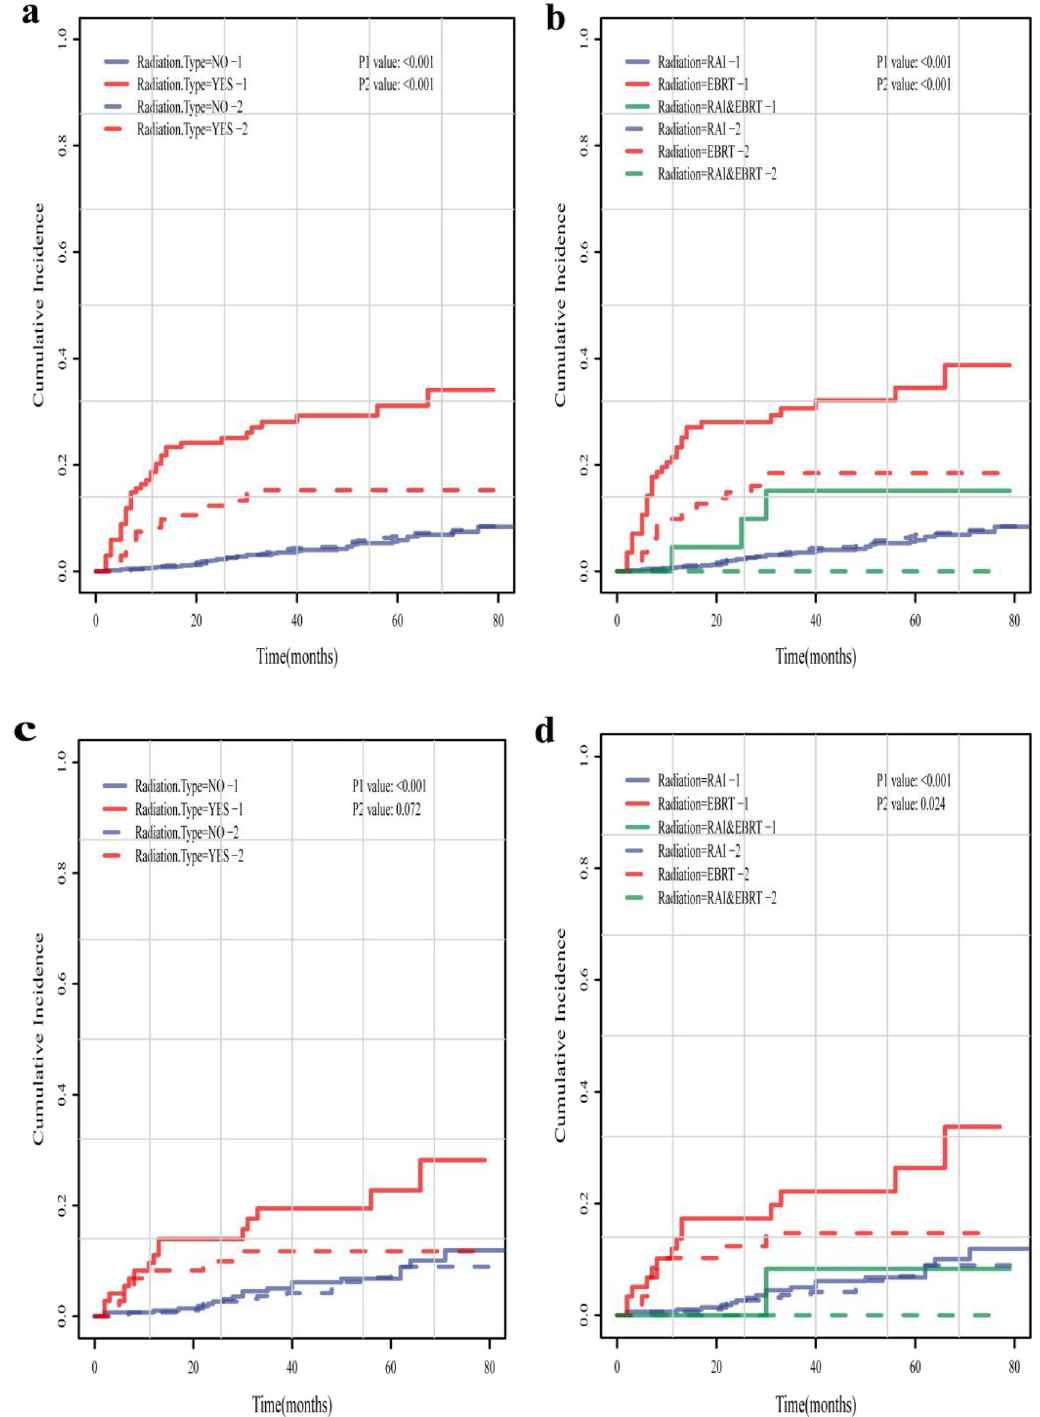
Figure 2. ( a ) Before propensity score-matched: cumulative incidence of the dichotomy variables. ( b ) Before propensity score-matched: cumulative incidence of the trichotomy variables. ( c ) After propensity score- matched: cumulative incidence of the dichotomy variables. ( d ) After propensity score-matched: cumulative incidence of the trichotomy variables [P1 is the P value of outcome = 1 (death of thyroid cancer); P2 is the P value of outcome = 2 (death not caused by thyroid cancer, competition